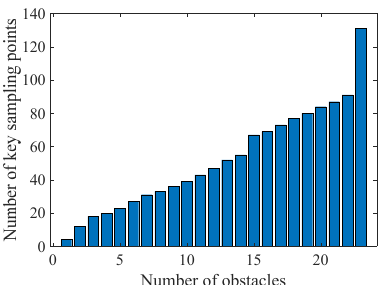
Figure 21. The number of sampling point changes with the increase of obstacle.